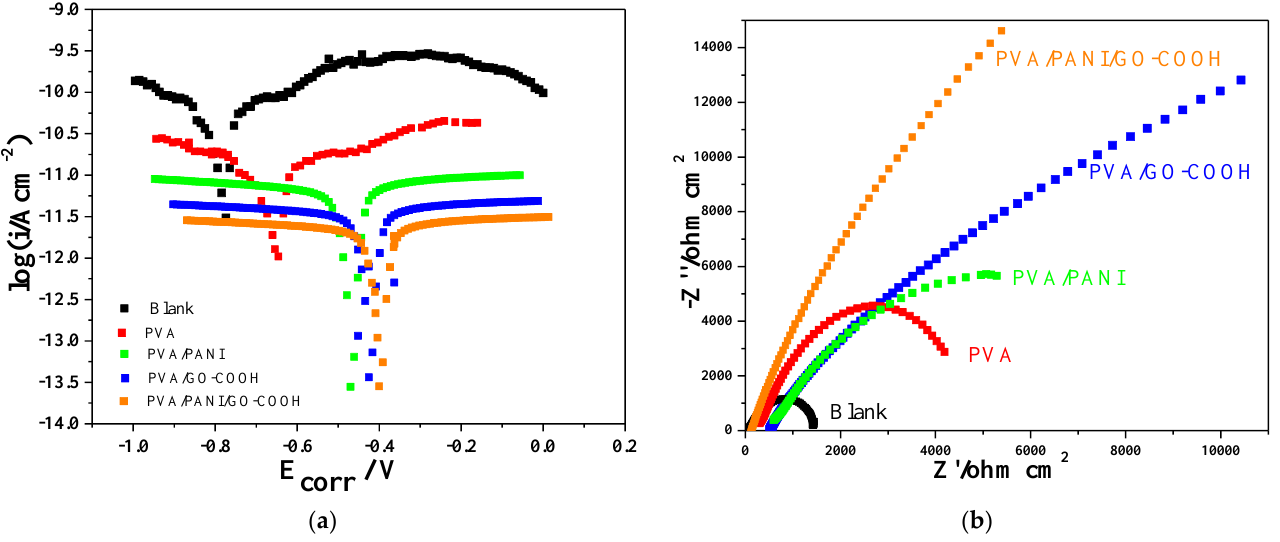
Figure 6. ( a ) Tafel polarization curves and ( b ) Nyquist plot of the coating samples after being immersed in 3.5 wt.% NaCl solution for 7 days.